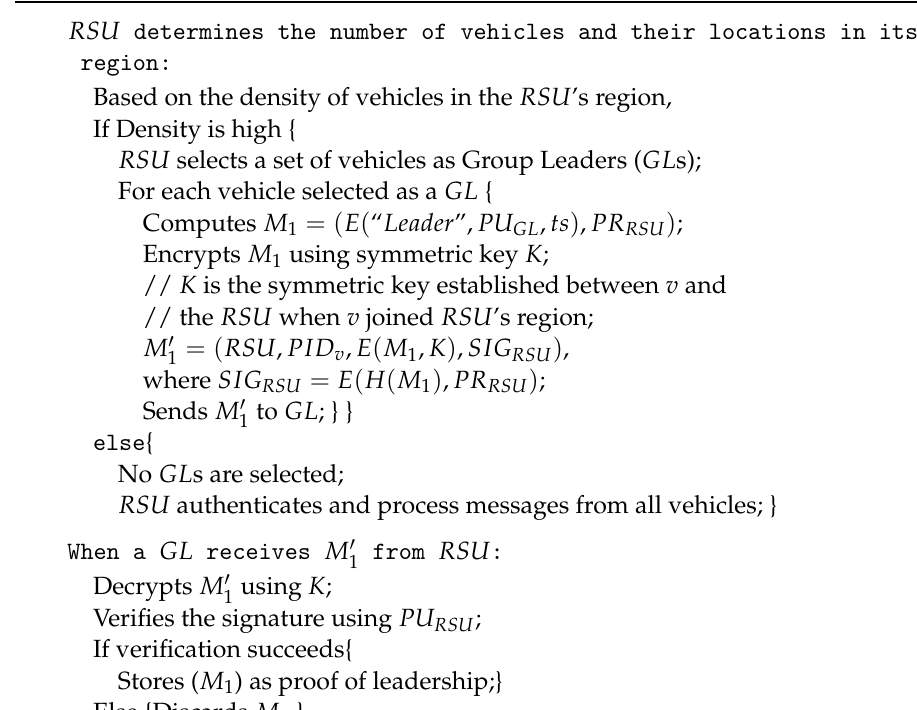
Algorithm 2: Assigning Group Leaders ( GL s) for selected vehicles by